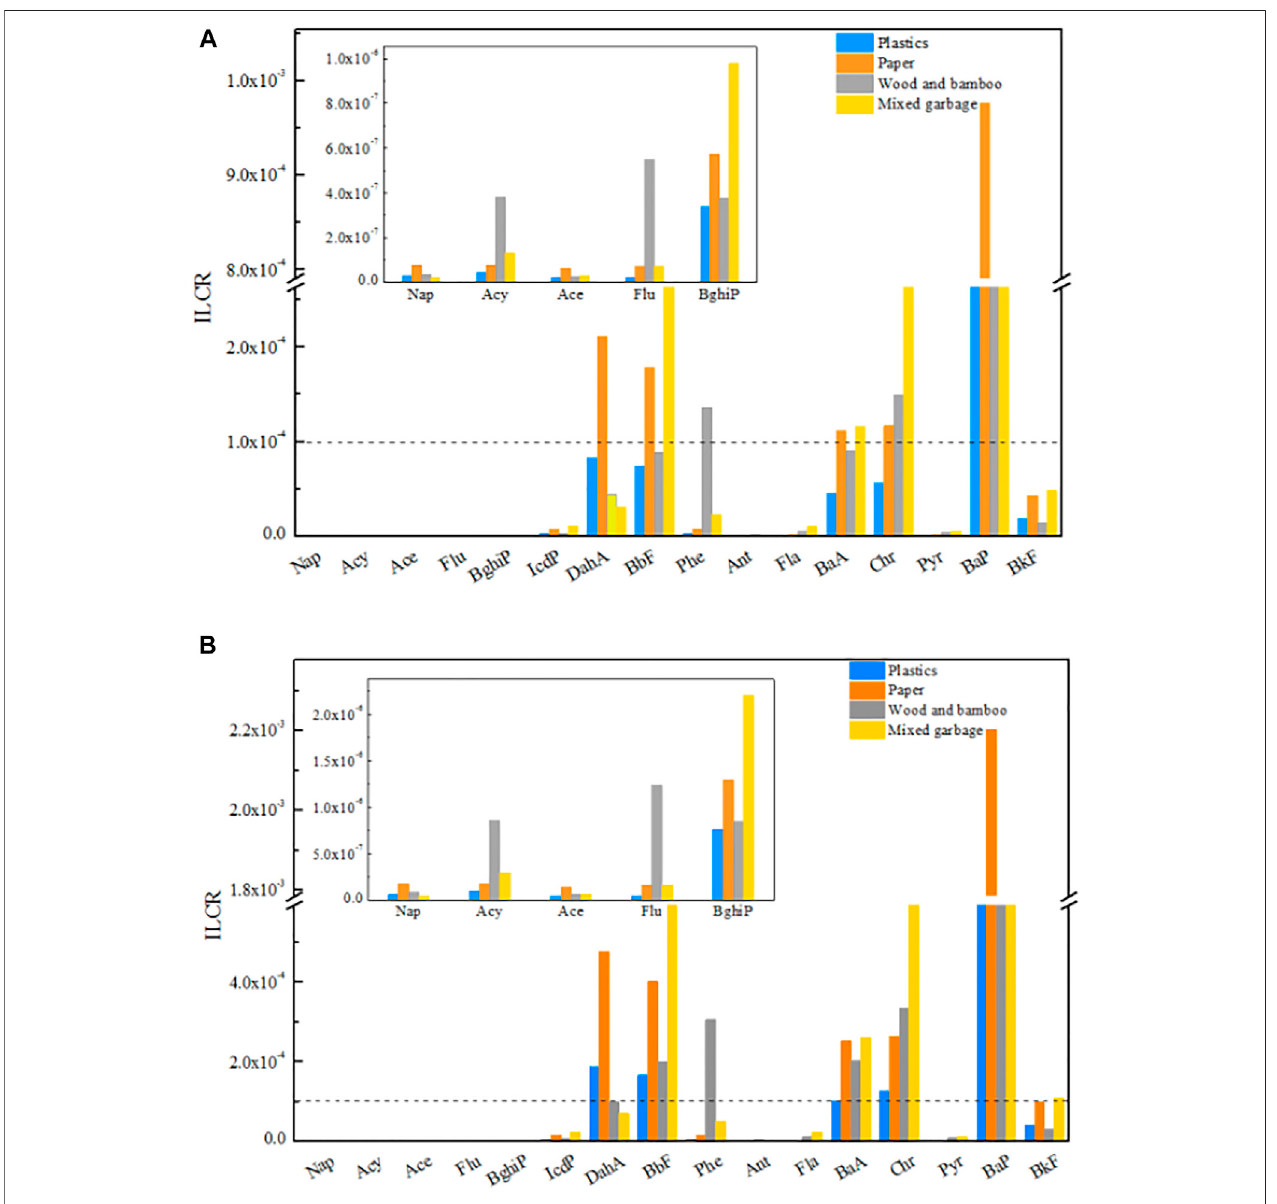
FIGURE 5 | Health risks of individual PAHs: (A) Children; (B)